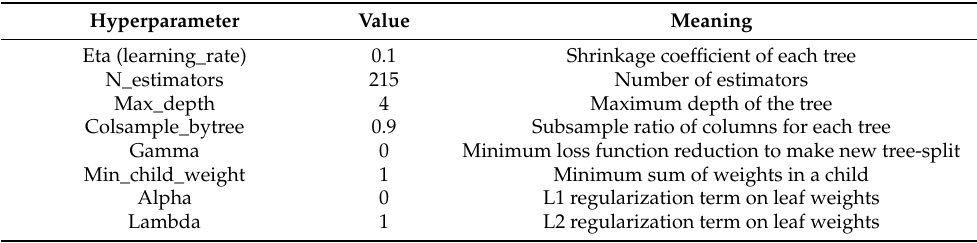
Table 1. Setting of hyperparameters for the developed XGBoost